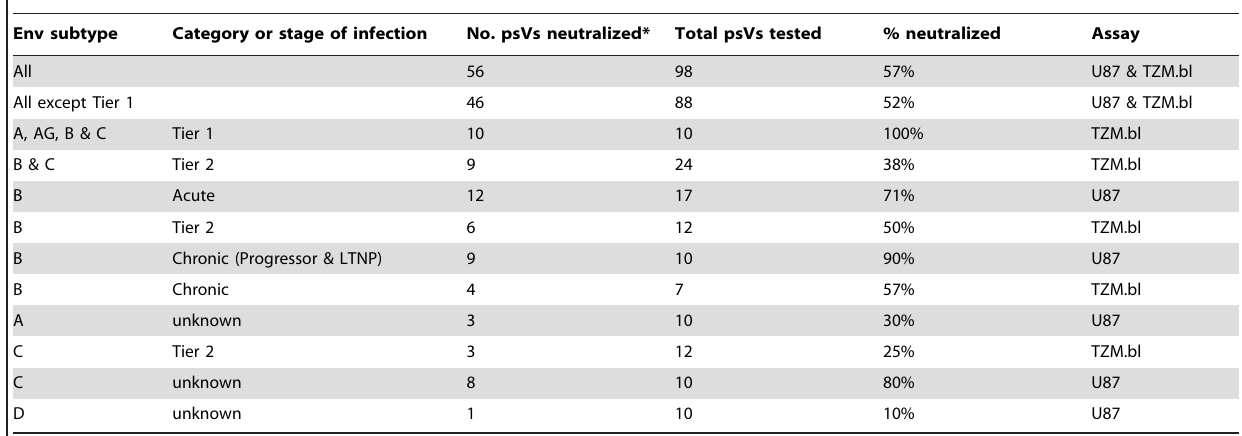
Table 2. Summary of data on psV neutralization by anti V3 mAbs.